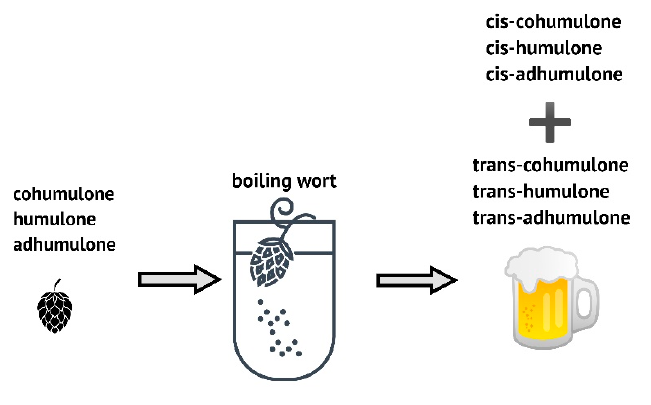
Figure 3. Scheme of α -acids isomerization to trans- and cis-forms.